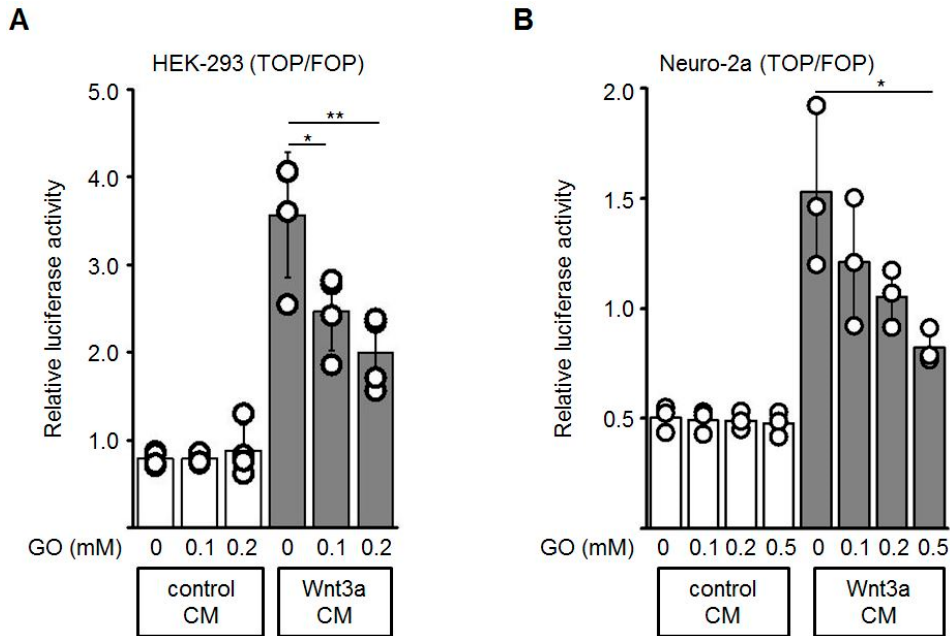
Figure 3. The stimulating activity of Wnt3a-conditioned media (Wnt3a CM) was suppressed after GO-treatment in reporter gene assays. HEK-293 ( A ) or Neuro-2a ( B ) cells were co-transfected with Topflash (TOP) or Fopflash (FOP) plasmids together with the Renilla plasmid, which was used as an internal control for transfection efficiency. Prior to control CM and Wnt3a CM stimulation, media were pre-incubated with indicated concentrations of GO for 3 h at 37°C, then added to the transfected cells for additional 18 h. Luciferase reporter activity was measured. The graphs show mean values ±SD of n = 3 independent experiments, each measured in duplicate. Circles represent individual experiments. Differences to non-glycated Wnt3a CM were analyzed by one-way ANOVA analysis. * p < 0.05, ** p < 0.01.